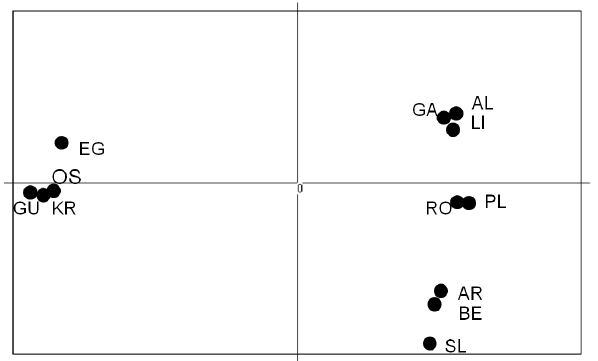
Figure 5. Bayesian clustering analysis of corkwing wrasse ( S. melops ) detected by STRUCTURE. A K=2 was the most likely